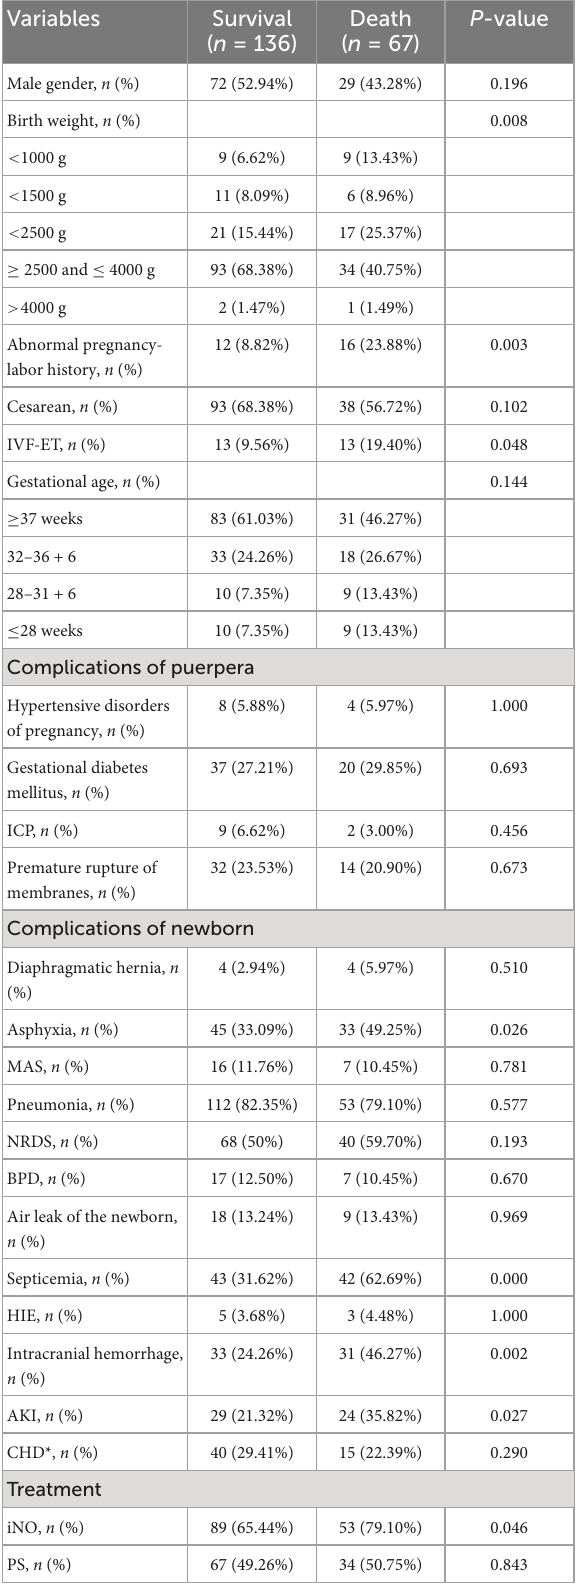
TABLE 1 Univariate analysis for risk